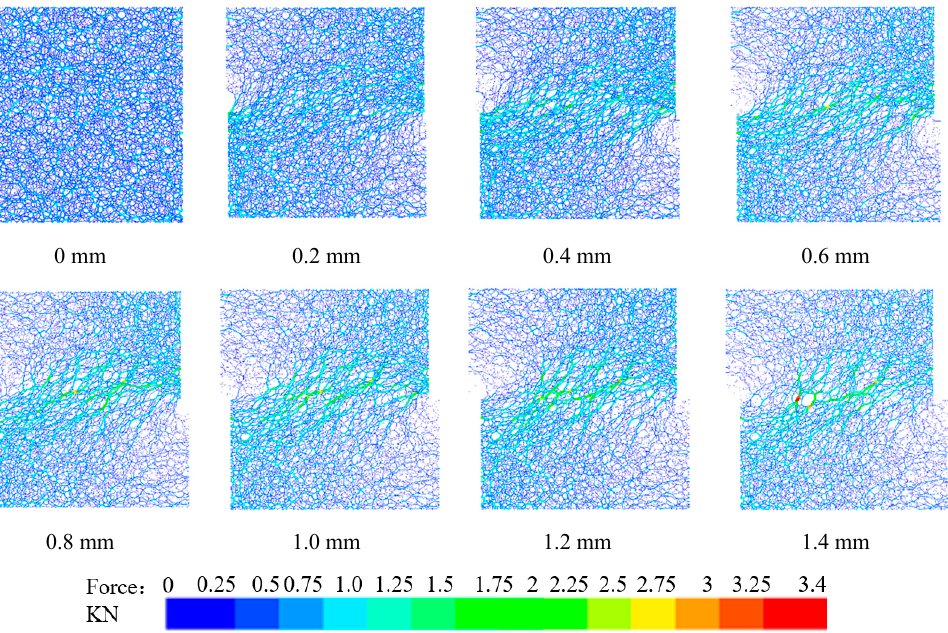
Figure 16. In the direct shear test, the contact force chain cloud diagram of natural gas hydrate deposits with normal stress of 1.2 MPa and saturation of 30%.